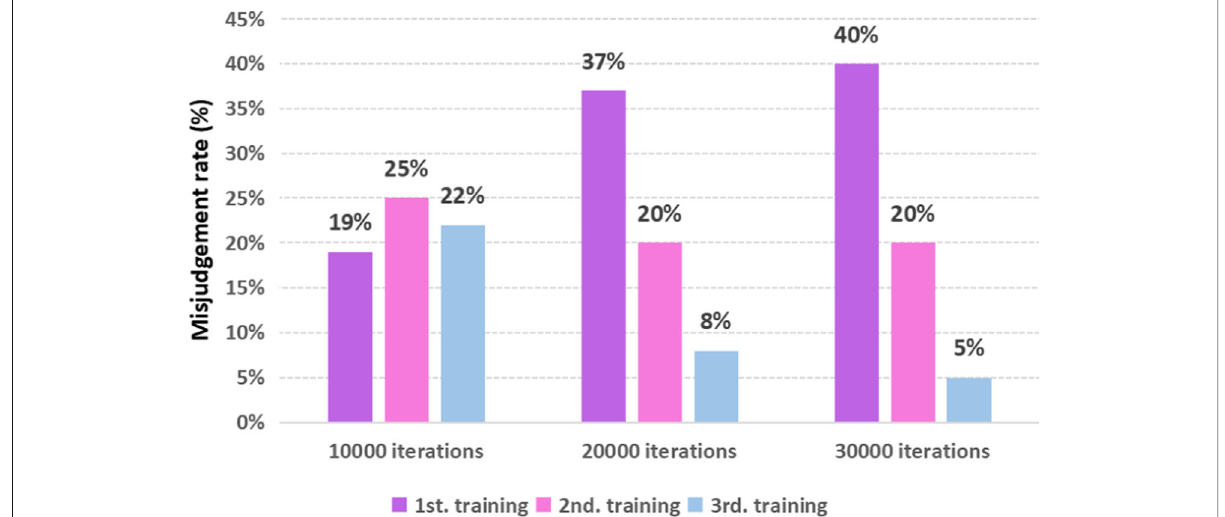
Fig. 10 Misjudgment rates of the three training